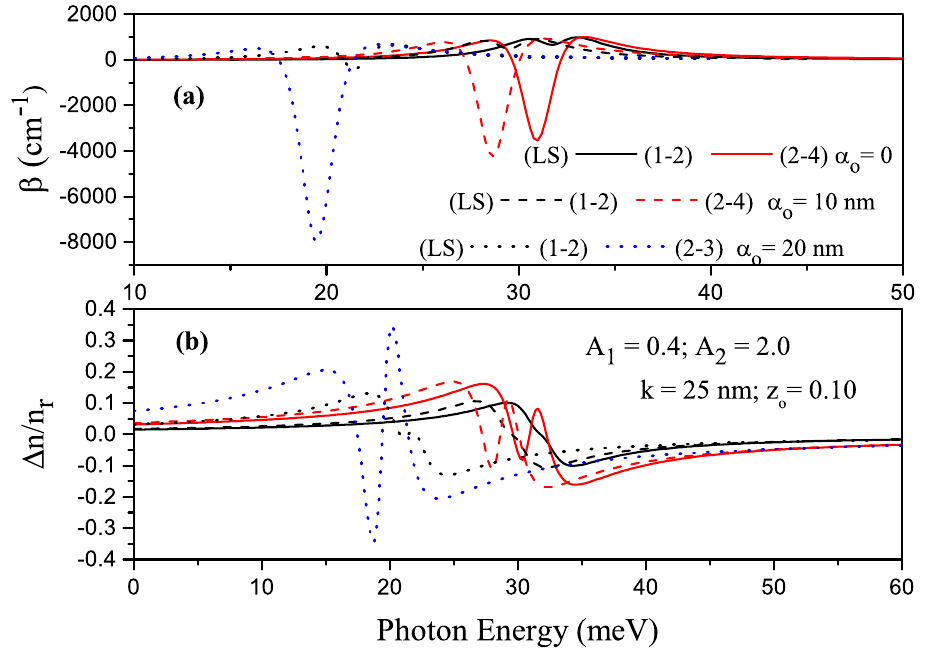
Figure 10. For some transitions in parabolic–Gaussian asymmetric DQW with k = 25nm, z o = 0.10, A 1 = 0.4 and A 2 = 2.0. ( a ) Variation in the total absorption coefficients concerning photon energy; ( b ) variation in total refractive index concerning photon energy. Solid, dashed, and dotted curves are for α o = 0, α o = 10nm, and α o = 20nm, respectively. Resonance conditions for ACs in Equations (4) and (5) are given with ¯ h ω max = (cid:113) (cid:0) (cid:1) 2 + (cid:0) (cid:1) 2 ( 1 ) ( ω ) . The maximal value of the linear AC in Equation (4) E ij − ¯ h ω ¯ h Γ ij and β max (cid:17) (cid:16) (cid:113) ( E − ¯ h ω ) 2 + ( ¯ h Γ ) 2 E ij + was directly proportional to the factor of | M ij | 2 . E ij is the ij ij